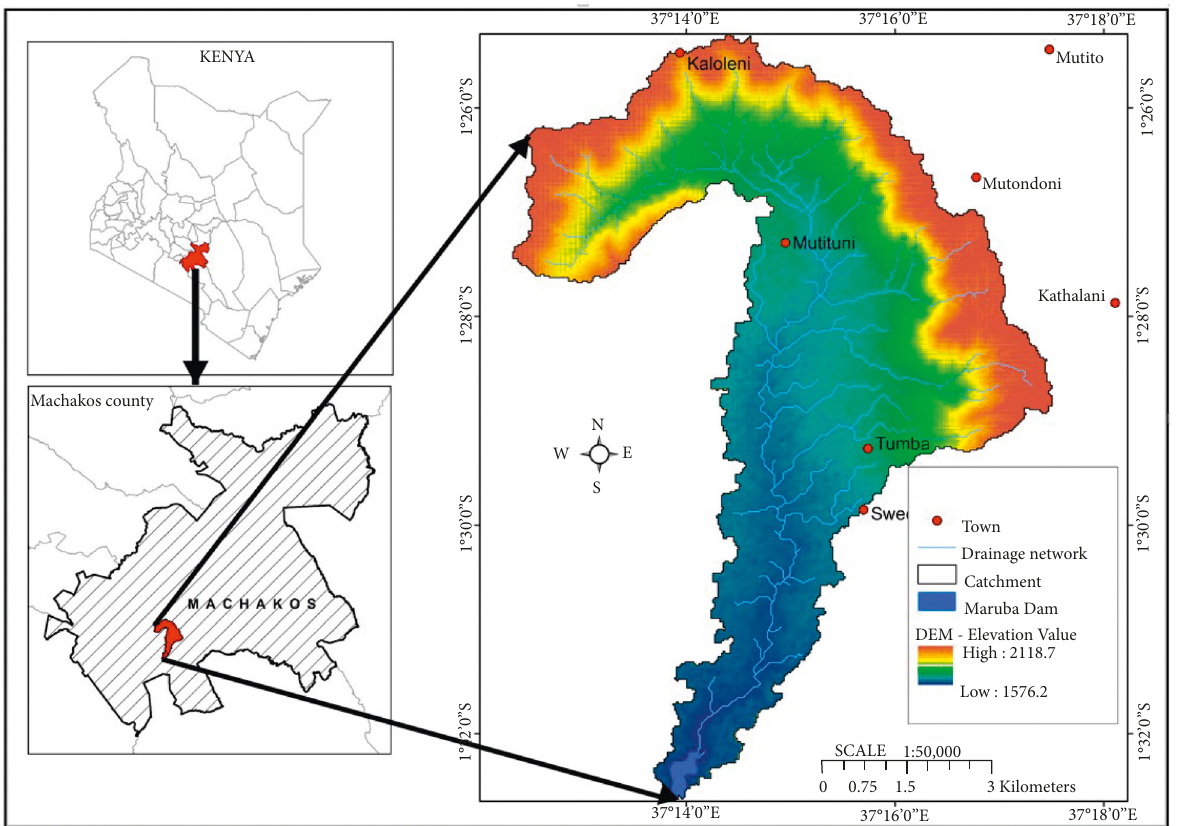
Figure 1: Location map for the study